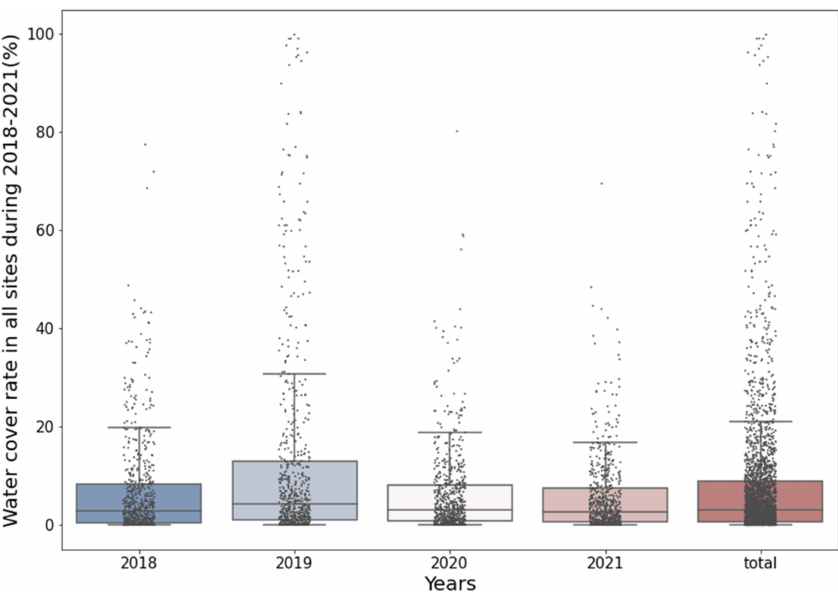
Figure 4. Surface water cover rate for each site in the four-year study period. The surface water cover rate by area in each category of CE sites is illustrated in Figure 5. Table 2 lists the percentage of inundated areas in each category of CE sites during 2018–2021. The results show that 7.85% of the CE land areas were under inundated con- ditions. The water cover condition results showed that significant inundation differences occurred over the years (mean surface water cover rates for 2018–2021 are 6.82%, 12.82%, 6.17%, and 5.61%, respectively). The year 2019 turned out to be a wetter year among the four years, with a surface water cover rate of 12.82%, which is much more than the mean value (7.85%). This study showed that 64.64% of the total area of all CEs in this study was not inundated, and 0.62% of the total area presented an over 90% (100% not included) chance of water cover from 2018 to 2021. Ultimately, 0.54% of the total area of all CE sites experienced 100% inundation during the past four years.